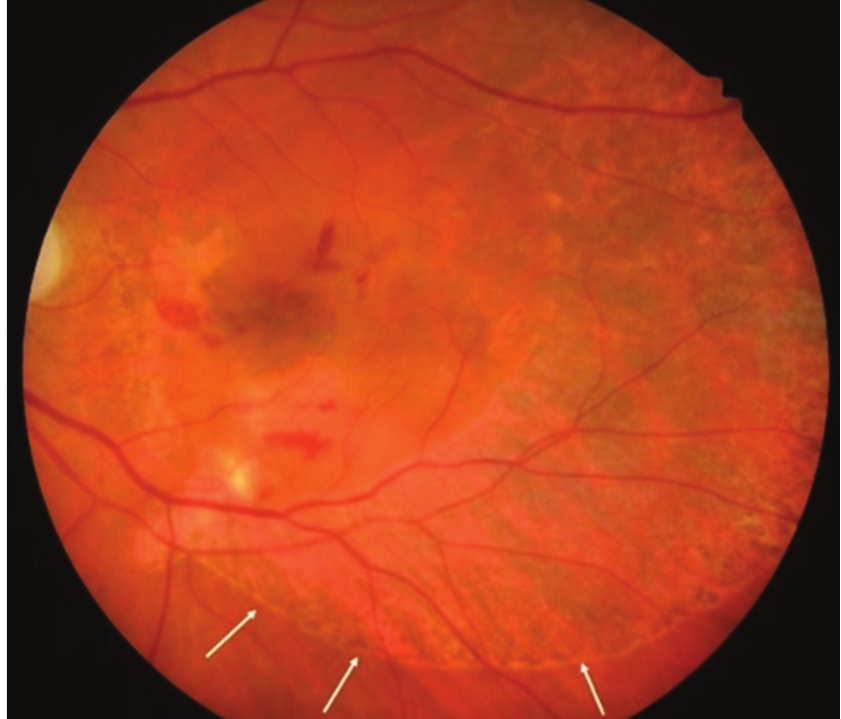
Figure 4. Color fundus photo demonstrating resolved submacular hemorrhage and RPE damage extending from the optic disc to the arcades and the temporal edge of the macula at one month postoperatively. Arrows demonstrate the extent of retinal pigment epithelium